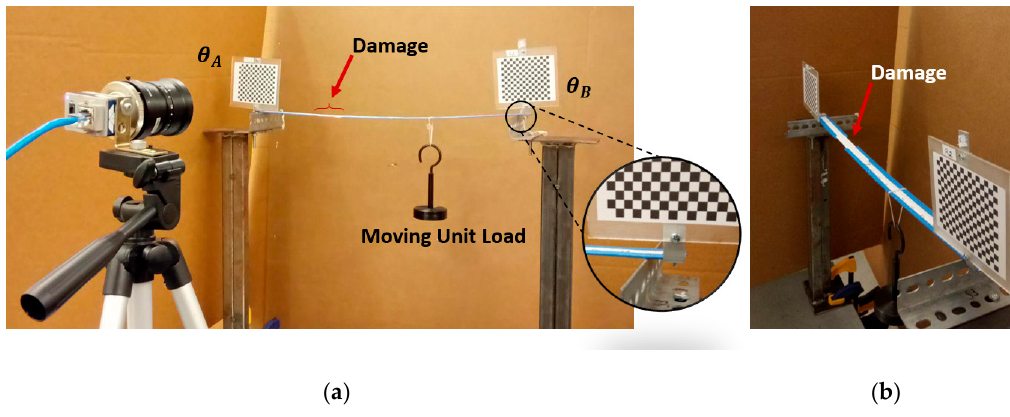
Figure 10. Experiment setup, ( a ) Front view, ( b ) Side view.